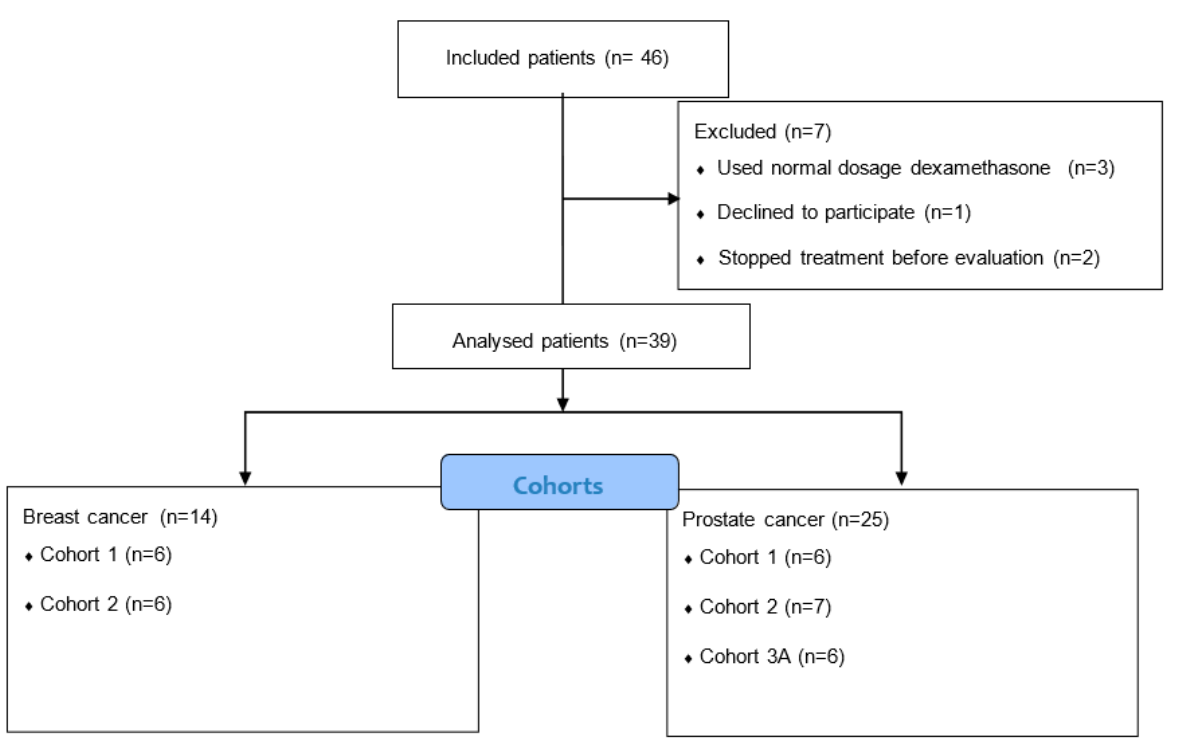
Figure 1. Consort diagram.